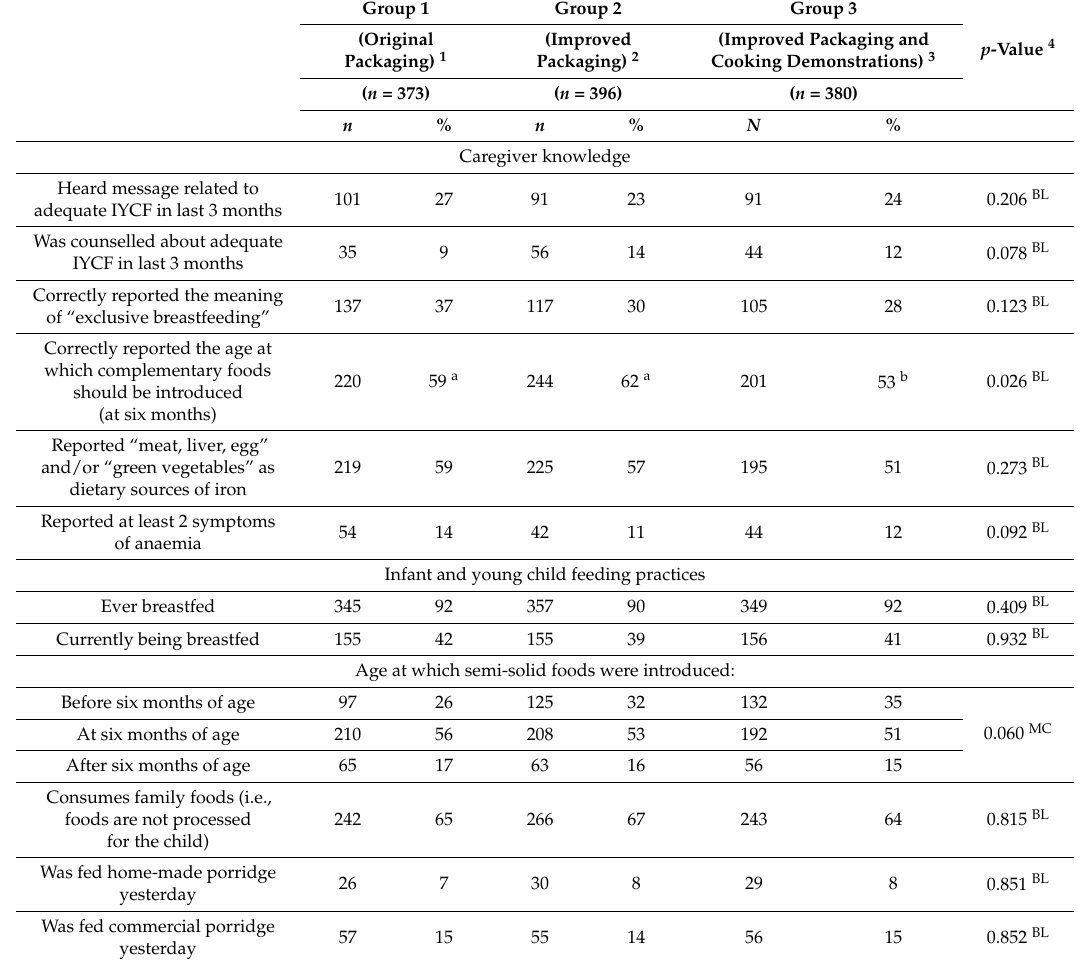
Table 3. Infant and young child feeding knowledge and practices at